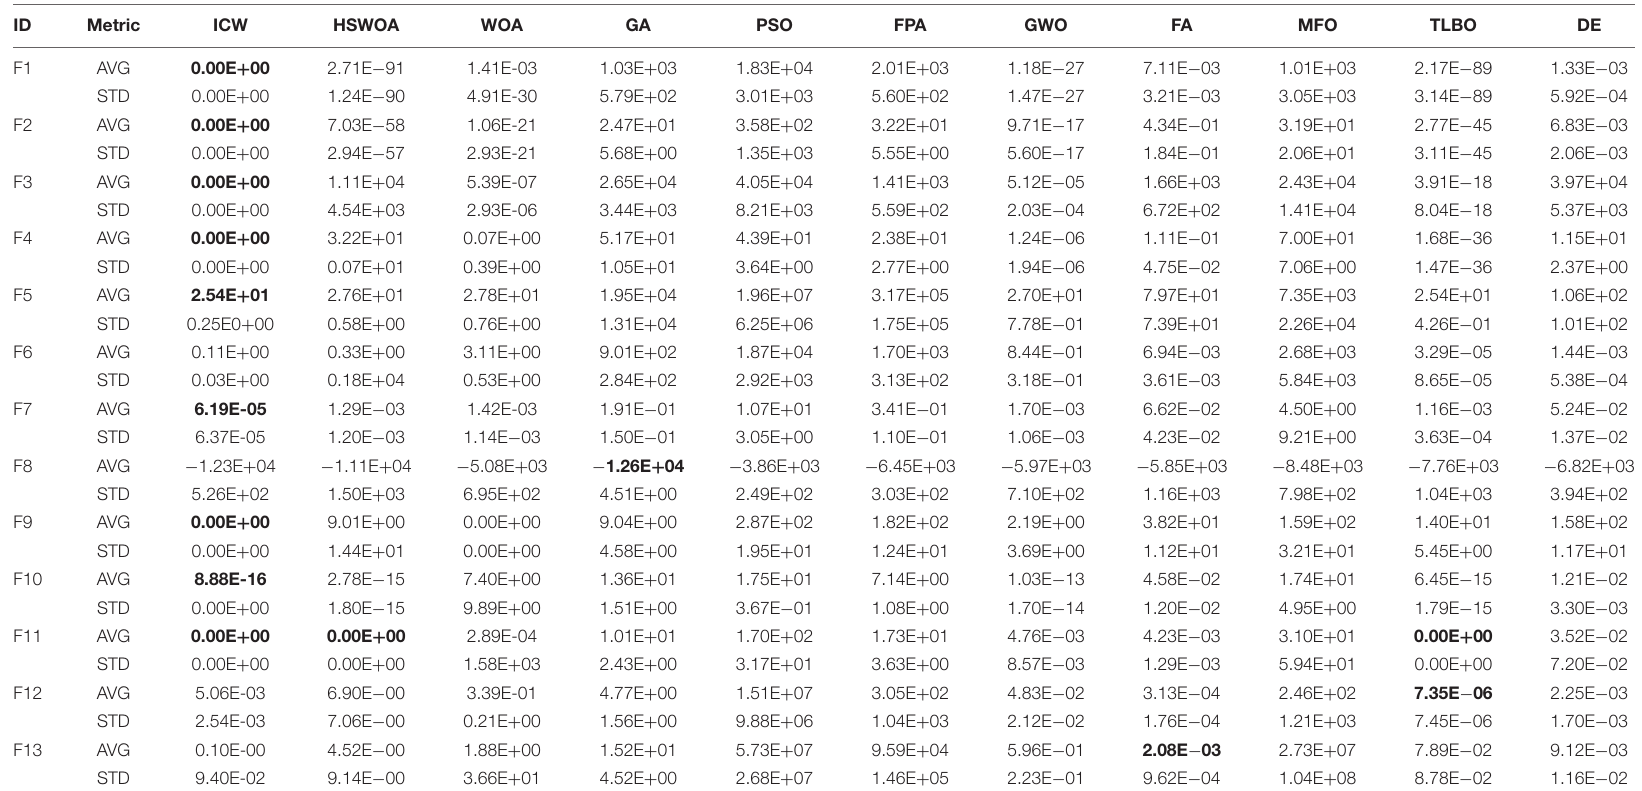
TABLE 1 | Result of benchmark functions (F1–F13) with 30 dimensions.